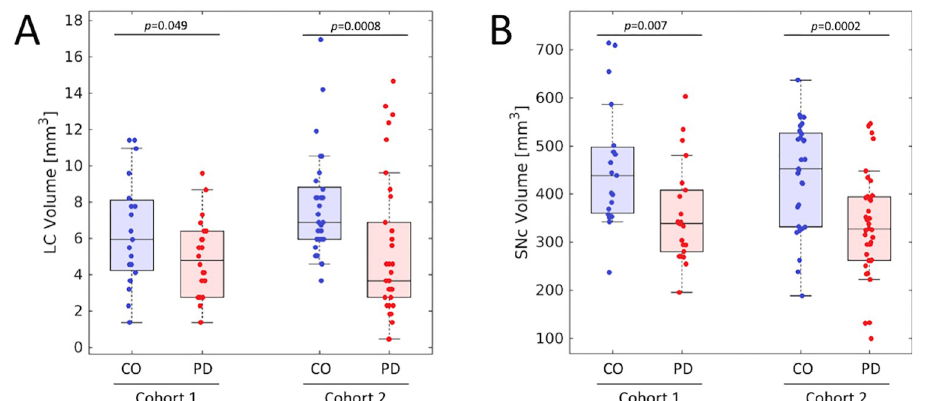
Fig 4. Group comparisons for LC volume (A) and SNc volume (B) in both cohorts. Similar reductions in LC and SNc volume are observed in both cohorts. In (A) and (B), the box denotes the 25 th and 75 th percentile, respectively, with the line denoting the median value.